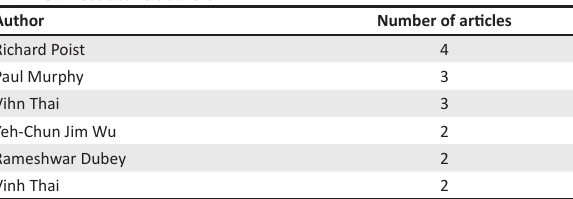
FIG URE 5: Percentage distribution of the studies by industry or sector. TABLE 3: Most active